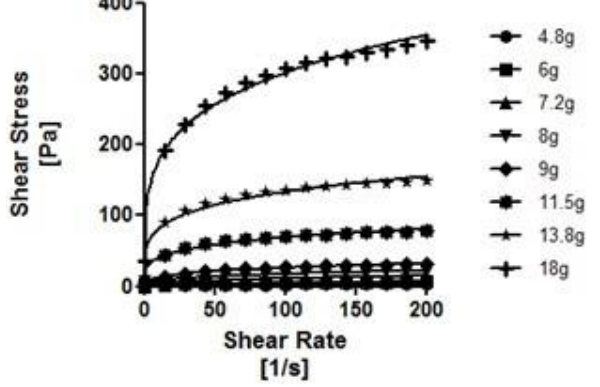
Figure 4. Flow curves at different concentrations of REA in water. Solid line represents the Ostwald rheological model de Waele.